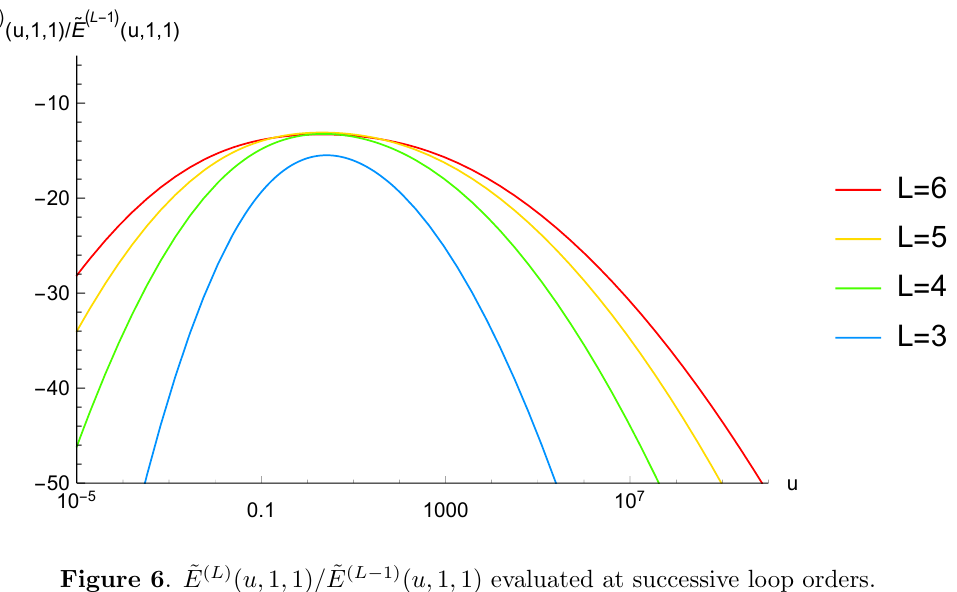
Figure 6 . ~ E ( L ) ( u; 1 ; 1) = ~ E ( L (cid:0) 1) ( u; 1 ; 1) evaluated at successive loop orders.